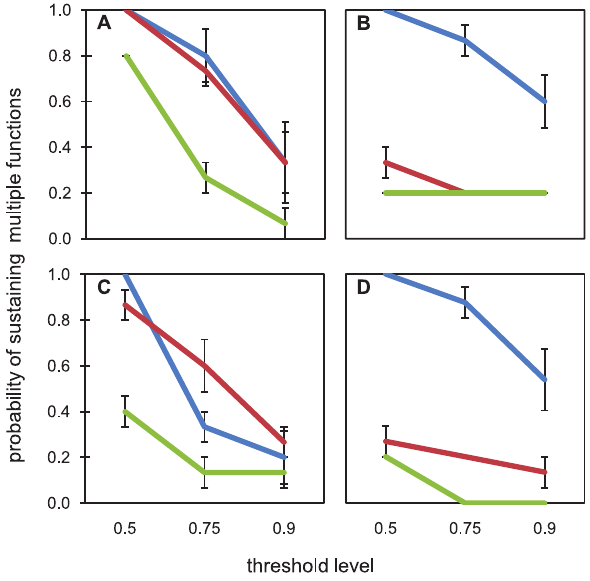
Figure 4. Probabilities for all 5 studied enzymes to be active above a threshold level of 0.5, 0.75 or 0.9 of the maximum activities. Shown are the probabilities for bioreactors fed with labile (A and C) and recalcitrant (B and D) organic carbon. Differences in the likelihood of sustaining joint functioning for young (A and B) and old (C and D) biofilms are shown. Blue lines represent the high diversity treatment, red lines the medium diversity treatment and the green lines the low diversity treatment. Error bars indicate s.e.m. N=3.